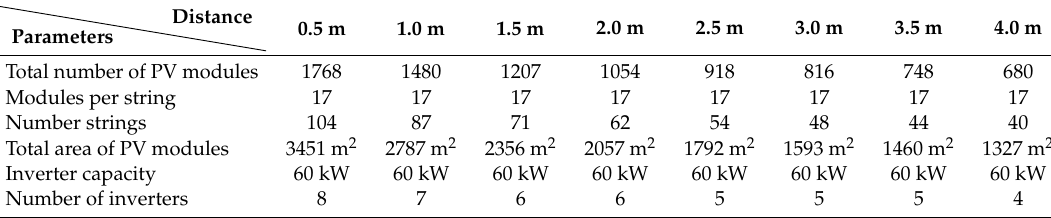
Figure 2. Layout of rooftop PV system for College of Engineering at Majmaah University (CEMU) building’s roof at interrow distance of 0.5 m. Table 3. Design summary.